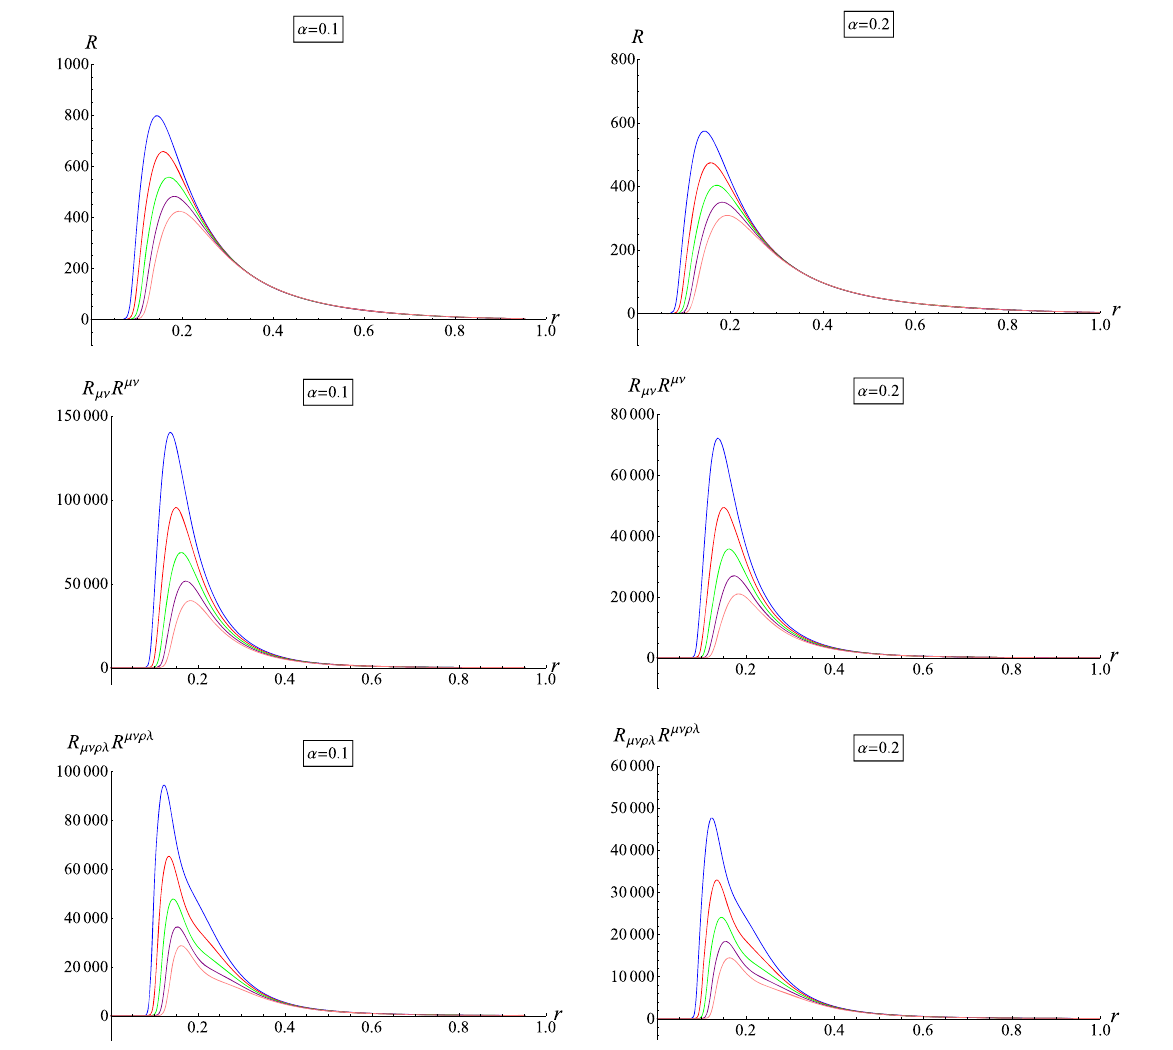
= 4 and l = 5. The 3 k